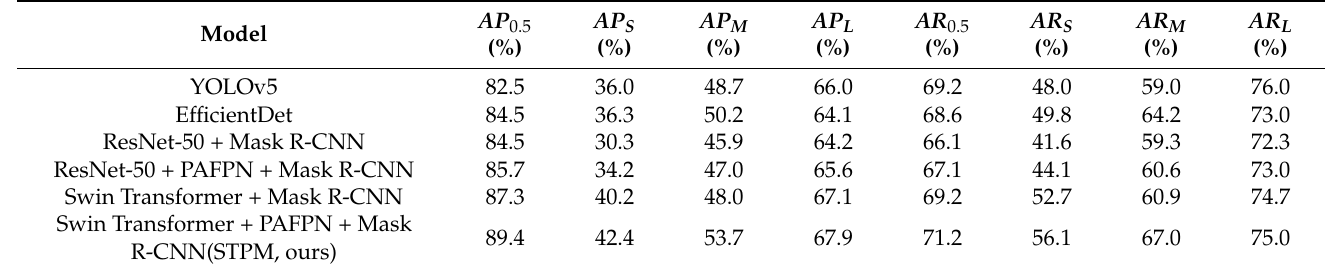
Table 5. Experimental results—detection accuracy of forest fires with different scales, using the Microsoft COCO evaluation indicators we introduced above.